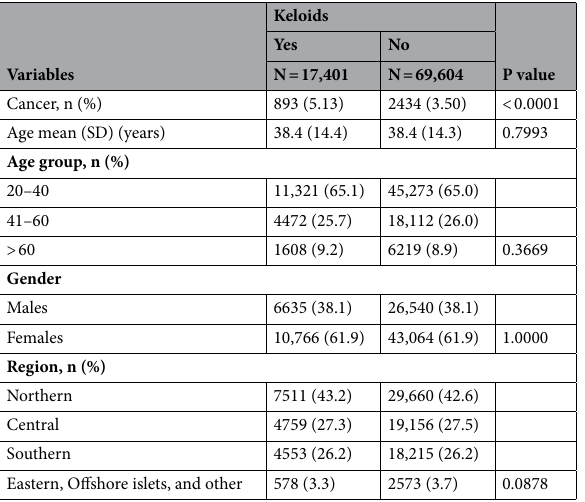
Table 1. The demographic characteristics of the keloids group and the control group. SD standard deviation.